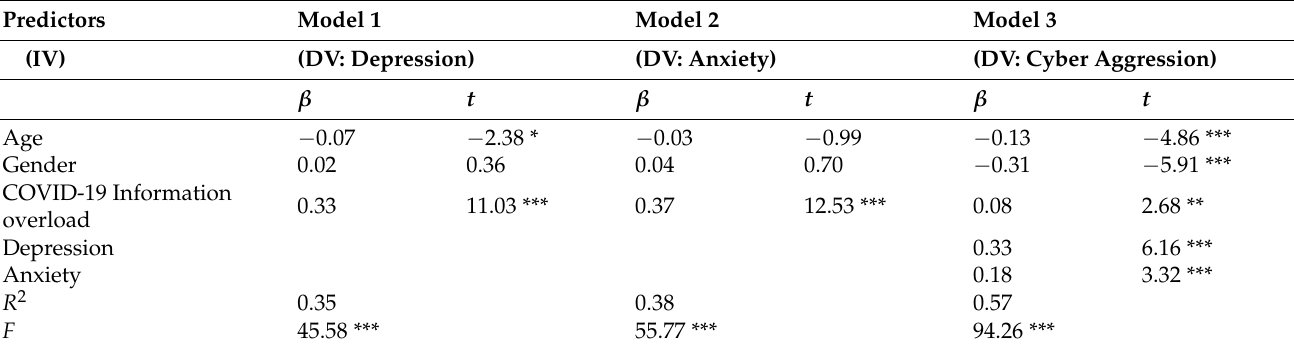
Table 2. Testing the mediation effect of COVID-19 information overload on cyber aggression.